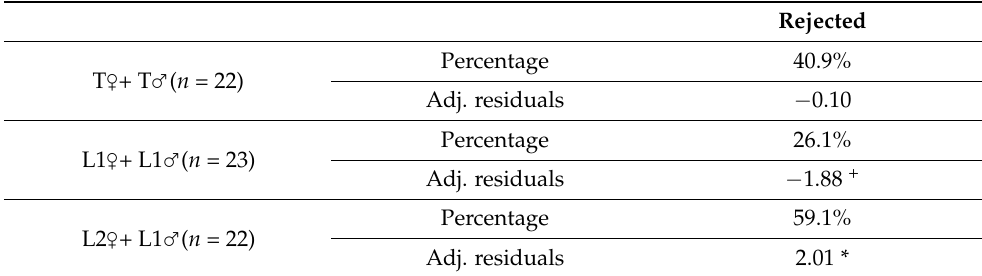
Table 10. Percentage of cases when female rejection occurred during the precopulation and the adjusted standardized